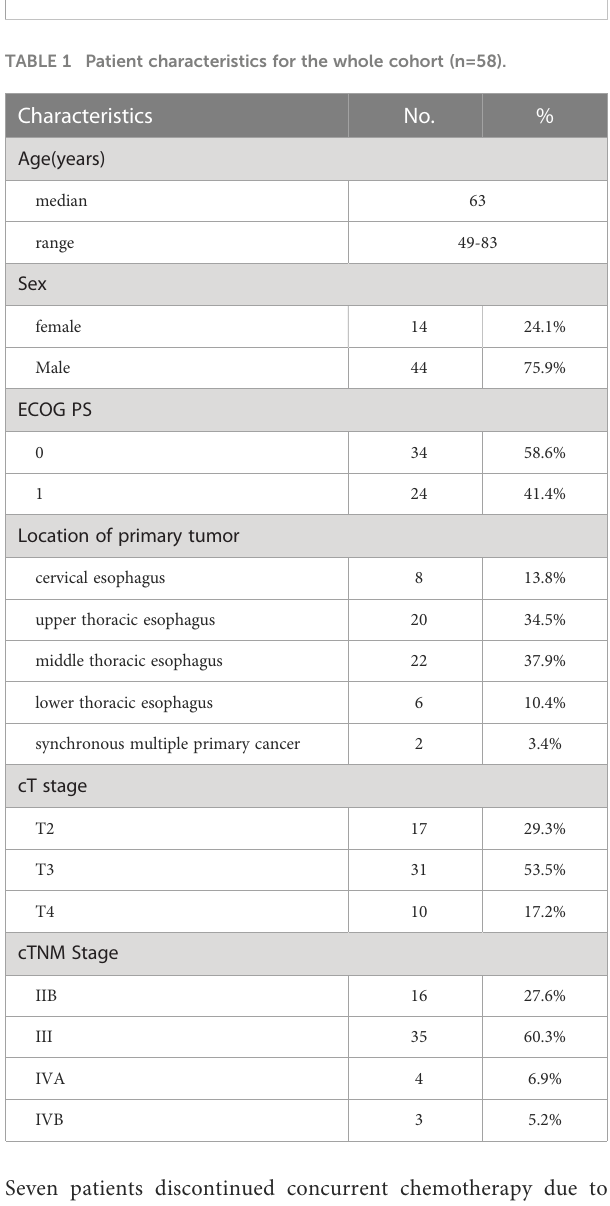
FIGURE 2 The fl ow chart of patient enrollment.